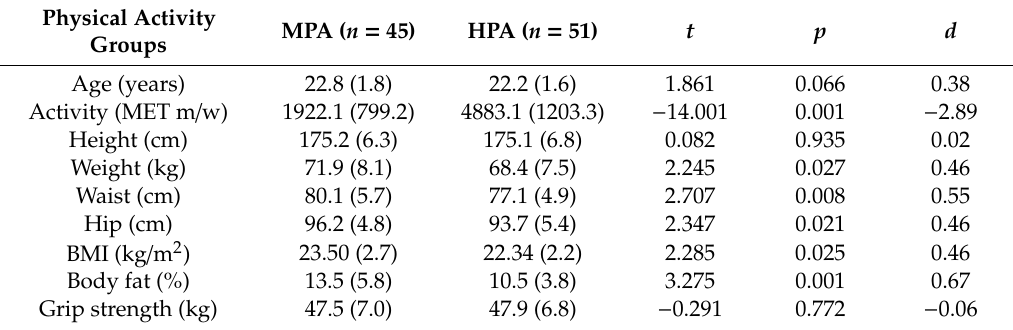
Table 1. Descriptive statistics, t-test results, and e ff ect size values for male participants.